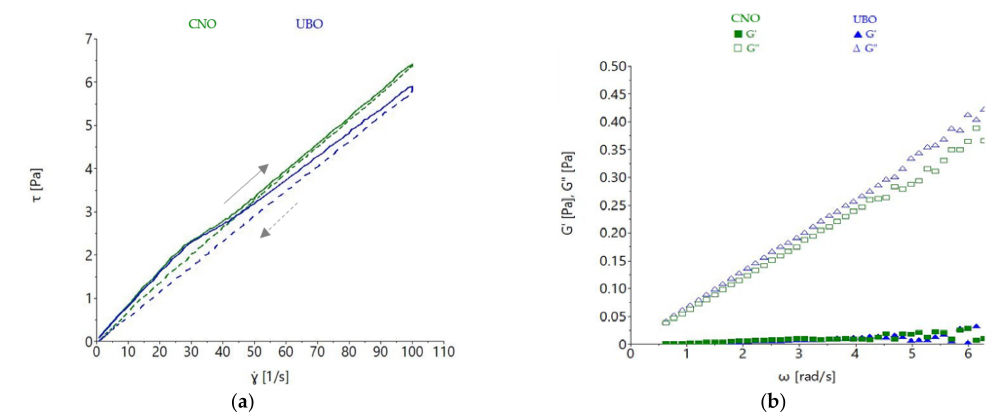
Figure 9. ( a ) Thixotropy loops of UBO— U. barbata extract in canola oil and CNO—canola oil, ( b ) variation of storage (G (cid:48) ) and loss (G”) moduli with frequency: UBO— U. barbata extract in canola oil, CNO—canola